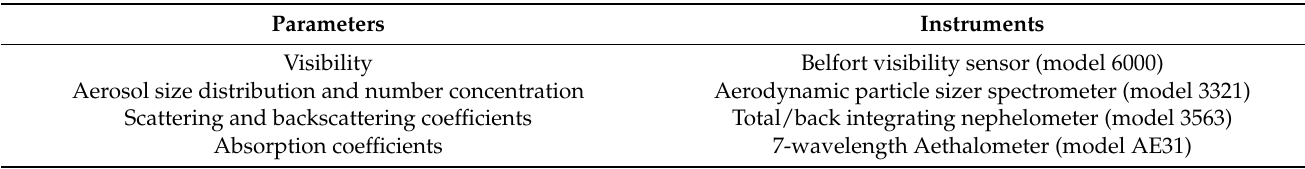
Table 1. Measured aerosol properties and related